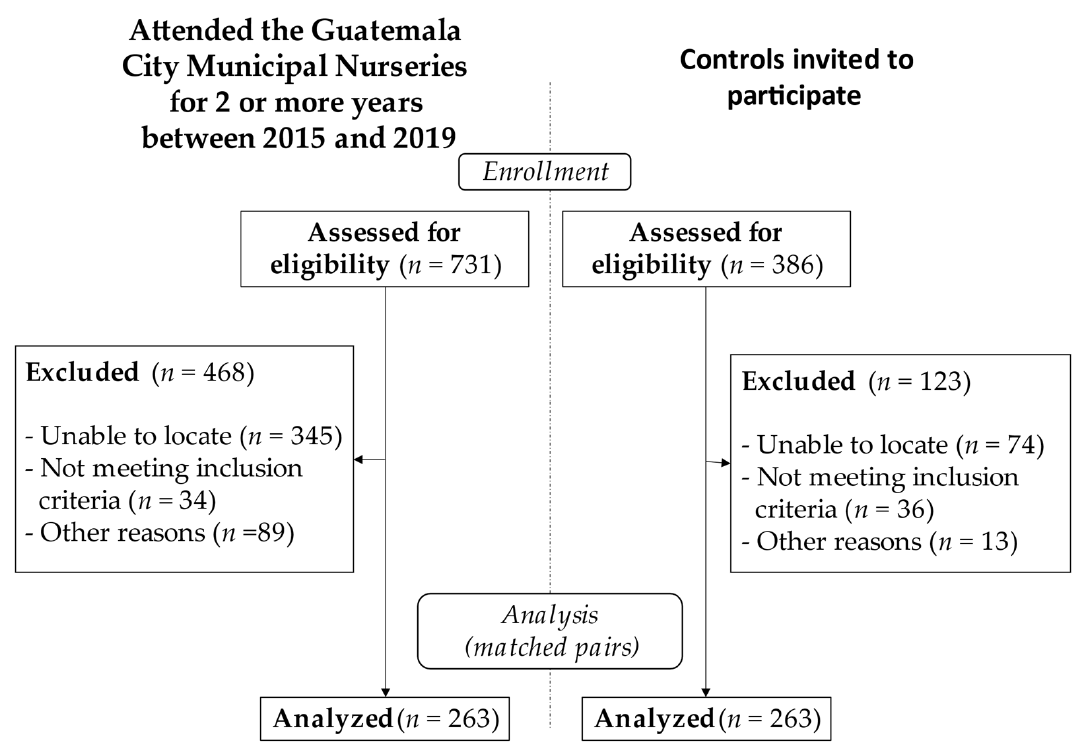
Figure 1. Consort Figure 1. Consort diagram.